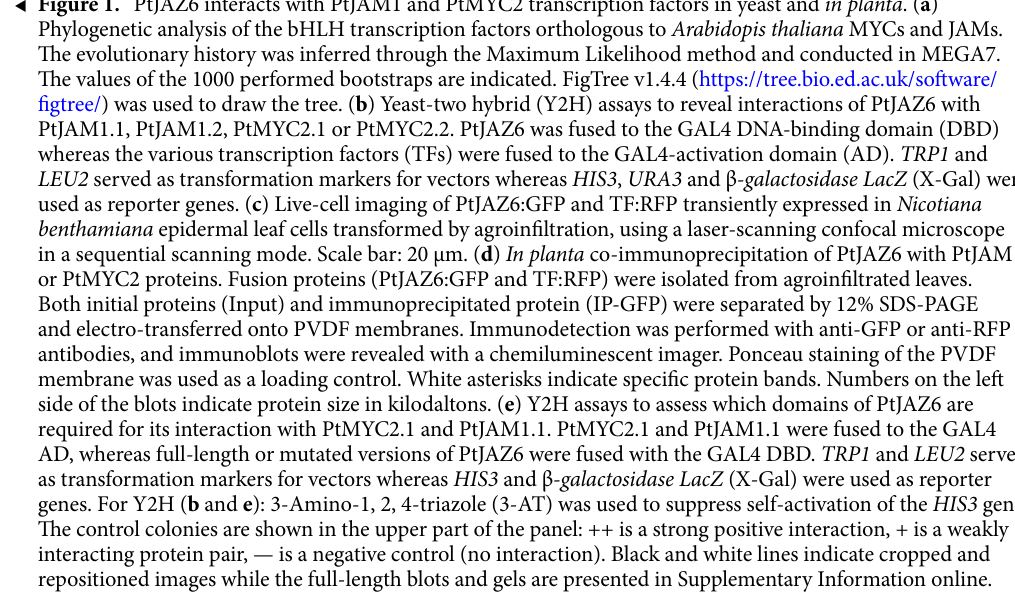
Figure 1. PtJAZ6 interacts with PtJAM1 and PtMYC2 transcription factors in yeast and in planta . ( a ) Phylogenetic analysis of the bHLH transcription factors orthologous to Arabidopis thaliana MYCs and JAMs. The evolutionary history was inferred through the Maximum Likelihood method and conducted in MEGA7. The values of the 1000 performed bootstraps are indicated. FigTree v1.4.4 (https ://tree.bio.ed.ac.uk/softw are/ figtr ee/) was used to draw the tree. ( b ) Yeast-two hybrid (Y2H) assays to reveal interactions of PtJAZ6 with PtJAM1.1, PtJAM1.2, PtMYC2.1 or PtMYC2.2. PtJAZ6 was fused to the GAL4 DNA-binding domain (DBD) whereas the various transcription factors (TFs) were fused to the GAL4-activation domain (AD). TRP1 and LEU2 served as transformation markers for vectors whereas HIS3 , URA3 and β -galactosidase LacZ (X-Gal) were used as reporter genes. ( c ) Live-cell imaging of PtJAZ6:GFP and TF:RFP transiently expressed in Nicotiana benthamiana epidermal leaf cells transformed by agroinfiltration, using a laser-scanning confocal microscope in a sequential scanning mode. Scale bar: 20 μm. ( d ) In planta co-immunoprecipitation of PtJAZ6 with PtJAM1 or PtMYC2 proteins. Fusion proteins (PtJAZ6:GFP and TF:RFP) were isolated from agroinfiltrated leaves. Both initial proteins (Input) and immunoprecipitated protein (IP-GFP) were separated by 12% SDS-PAGE and electro-transferred onto PVDF membranes. Immunodetection was performed with anti-GFP or